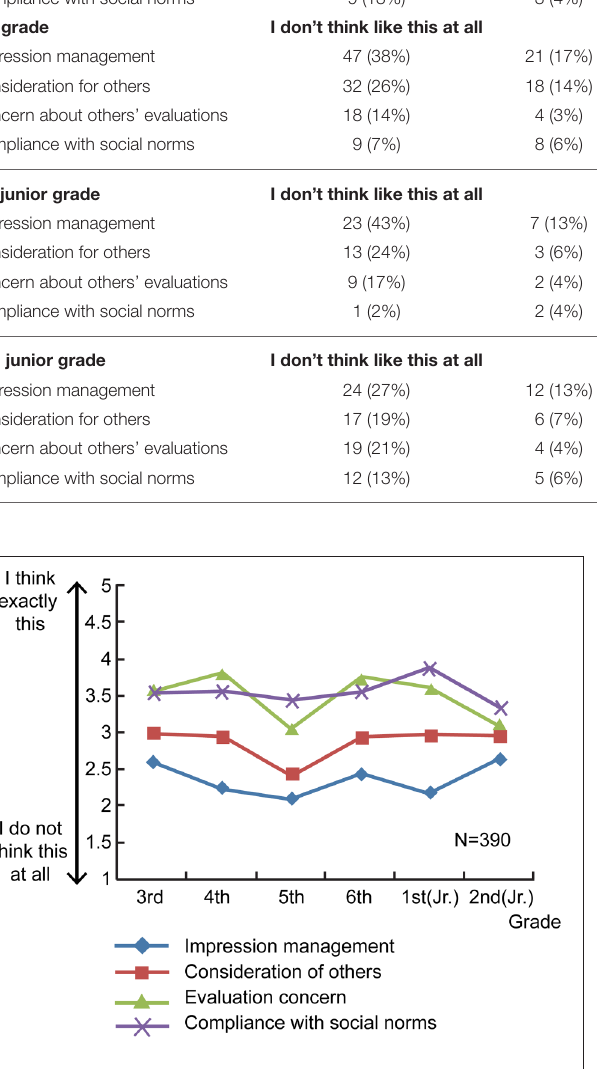
FIGURE 3 | Average admission ratings across each grade level and motive (motives for